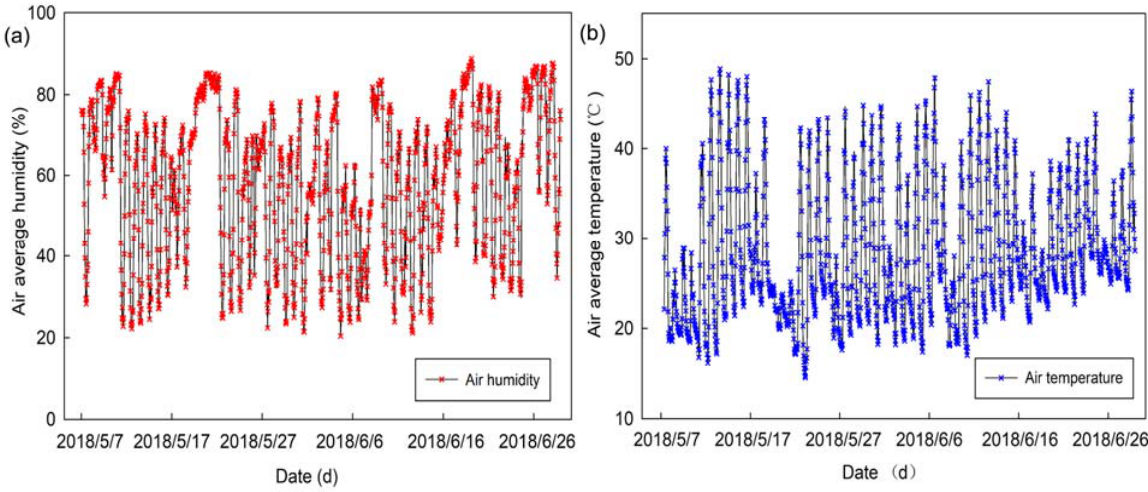
Figure 2. Timing diagram of environmental parameters in the Greenhouse A. ( a ) Average humidity of the air every hour and ( b ) temperature.